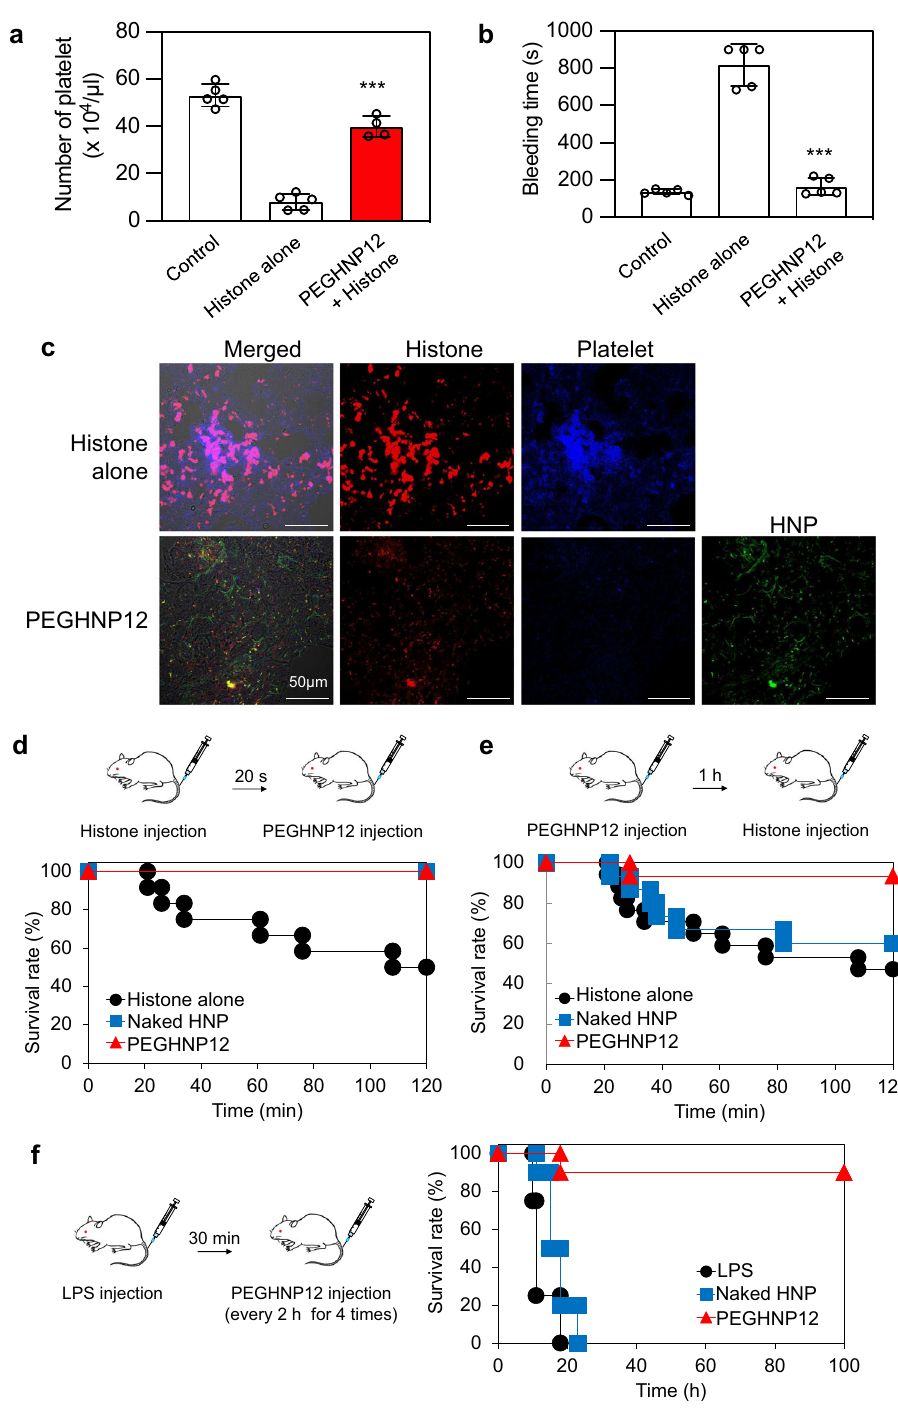
Fig. 6 Protection of mice from septic lethality by HNPs in vivo. a Number of platelets after injecting histones and/or HNPs. Histones (40 mg/kg) were injected into mice 1h after injecting HNPs (10mg/kg). Twenty minutes after the injection, the number of platelets was measured. Signi fi cant difference; *** p <0.0001 vs. Histones alone. Data represent the means±s.d. n = 4 – 5. Data represent the means±s.d. n = 4. Differences within a group were evaluated by one-way ANOVA with the Tukey post hoc test. b Tail bleeding time after injecting histones and/or PEGHNPs. Histones (40 mg/kg) were injected into mice 1h after injecting HNPs (10 mg/kg). Twenty minutes after the injection, the time of bleeding from the tail was measured. Signi fi cant difference; *** p <0.0001 vs. Histones alone. Data represent the means±s.d. n = 4 – 5. Data represent the means±s.d. n = 4. Differences within a group were evaluated by one-way ANOVA with the Tukey post hoc test. c Immunostaining of lungs after injecting histones and/or HNPs. Cy5-histones (40mg/kg) were intravenously injected into mice 1h after FITC-PEGHNP injection (10 mg/kg). Twenty minutes after the histone injection, the frozen section of the lungs was stained with CD41. Red: histones; blue: platelets; green: HNPs. Bar: 0.05mm. d Survival rate of mice intravenously treated with PEGHNPs (10 mg/kg) at 20s after the injection of histones (75mg/kg). e Survival rate of mice intravenously treated with histones (75mg/kg) at 1h after the injection of PEGHNPs (10 mg/kg). f Survival rate of LPS-induced (15mg/kg) sepsis model mice improved by the injection of PEGHNP12 (10 mg/kg). LPS